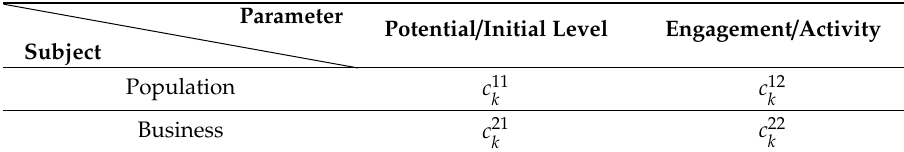
Table 2. A set of “element states” of the information society.